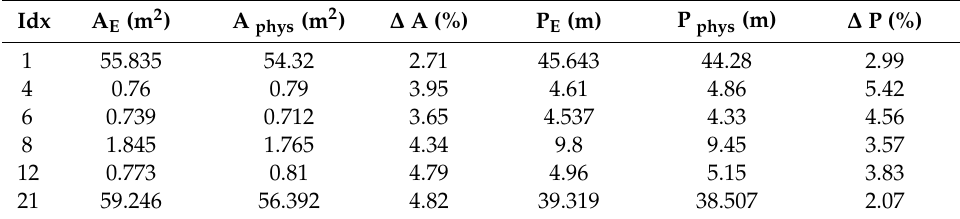
Table 7. Physical area and perimeter, di ff erence in percent (Z-axis).